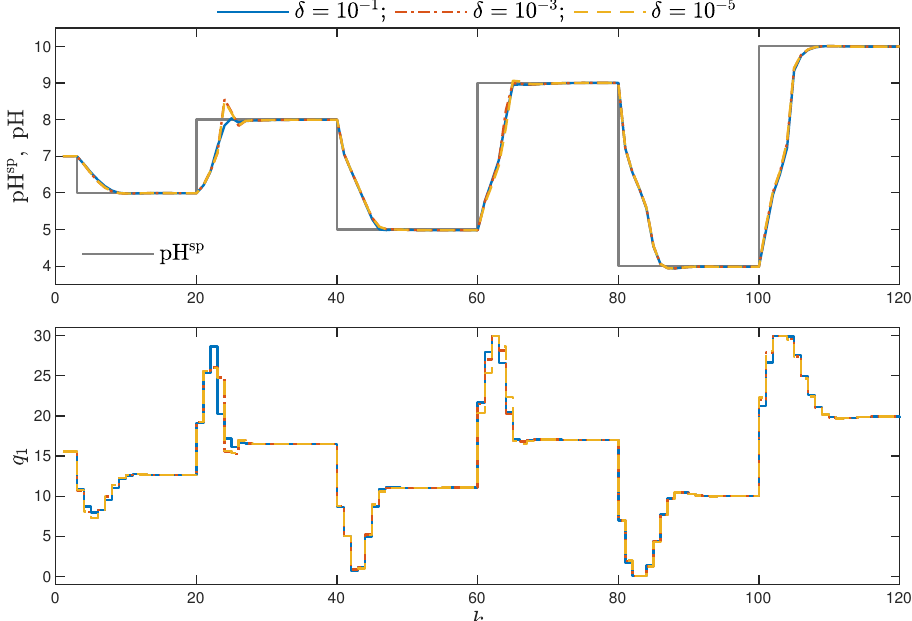
Figure 5. Simulation results: the MPC-NPLPT-L 1 algorithm for three values of the parameter δ .